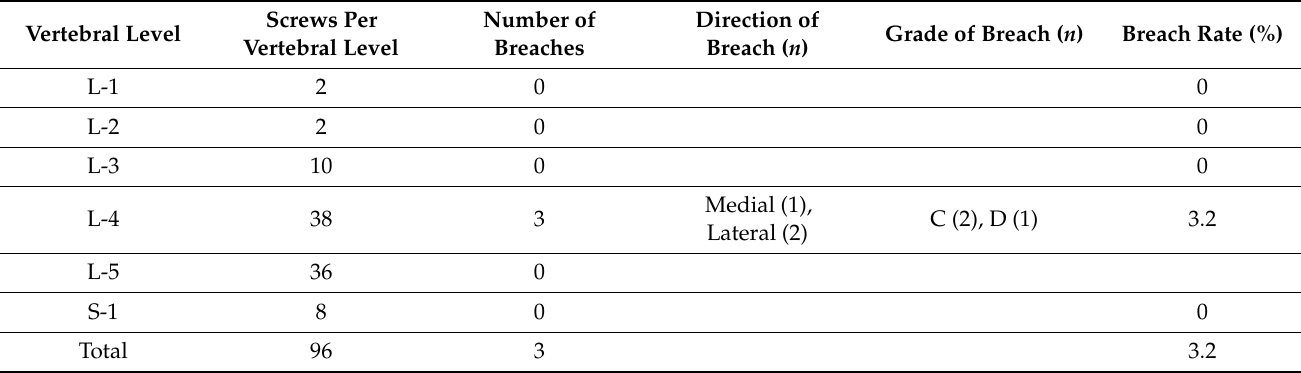
Table 4. Pedicle screw breach rate (total and per vertebral